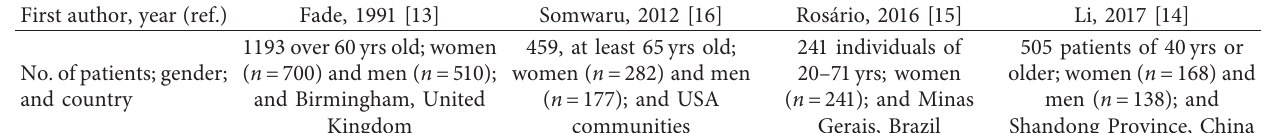
Table 1: TSH in the natural history of subclinical